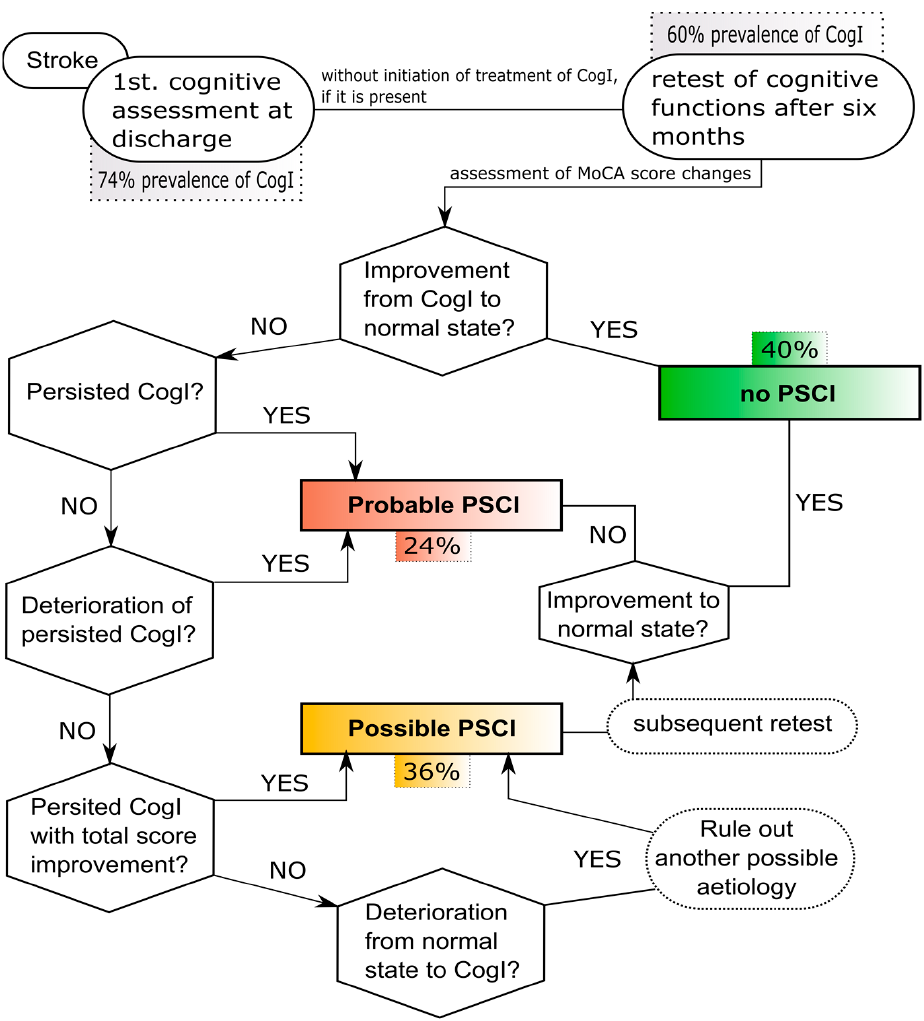
Figure 4. Based on our clinical experience, observation of changes in cognitive functions in patients after Ischaemic stroke, and available prevalence and overview studies, we proposed this algorithm for diagnosis of probable and/or possible PSCI.